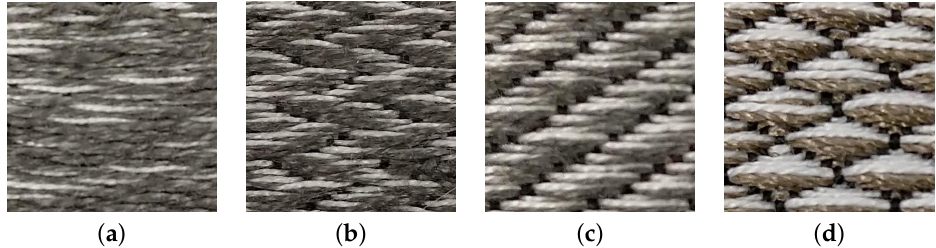
Figure 3. ( a ) Sateen: lowest anchoring, highest skin contact with the conductive portion of the electrode. ( b ) Broken twill: medium anchoring and skin contact. ( c ) Twill: medium anchoring and skin contact. ( d ) Birdseye: highest anchoring, lowest skin